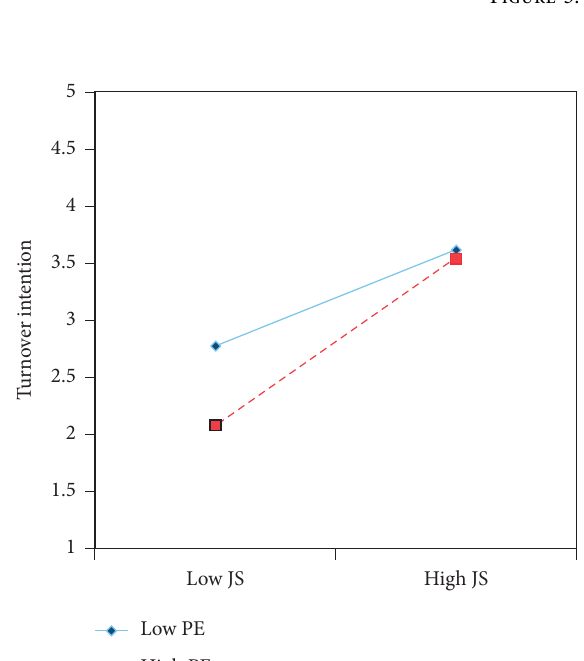
Figure 3: Structural model.